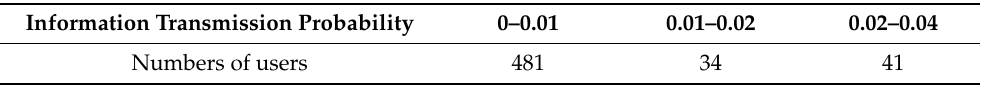
Table 4. Transmission probability statistics of